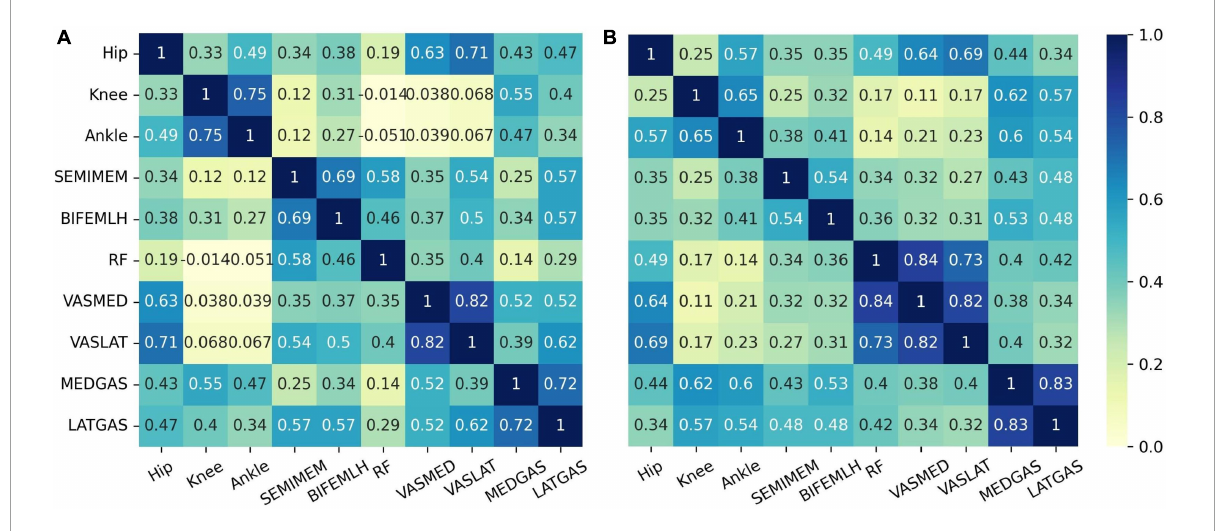
the gender information. The experiment results are shown in Figure 7